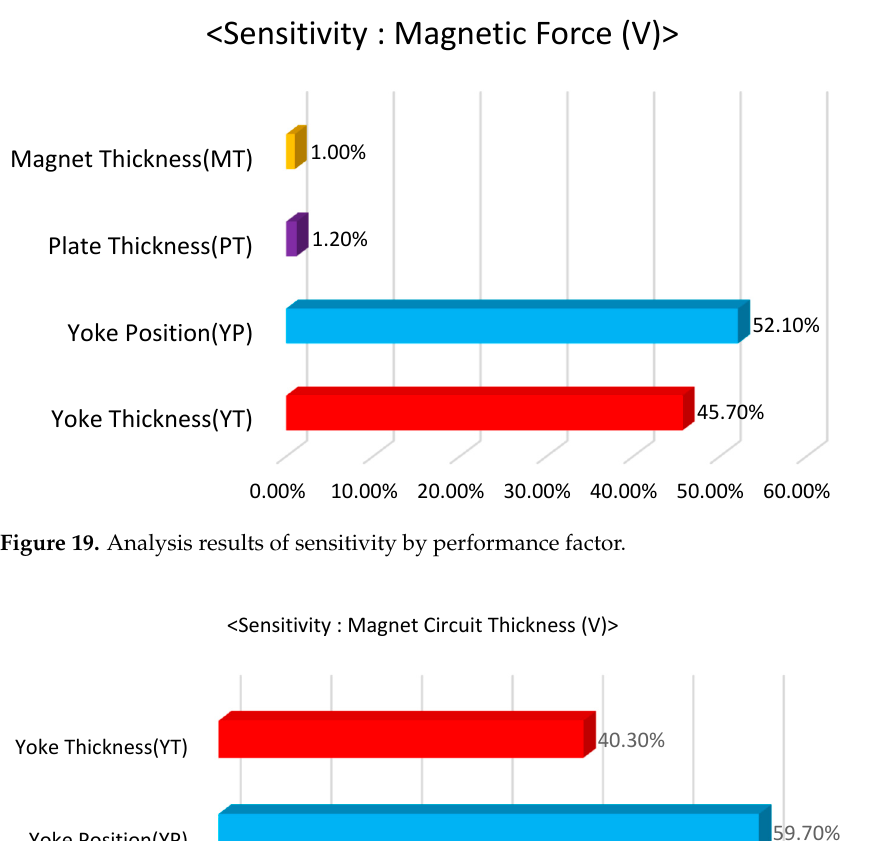
Figure 18. The performance distribution of thickness minimization by design tolerance.